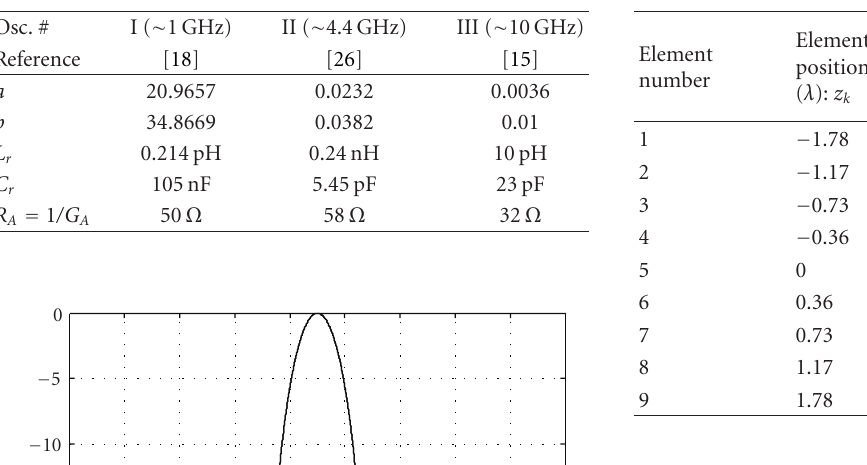
Table 1: Van der Pol parameters of the employed oscillators.